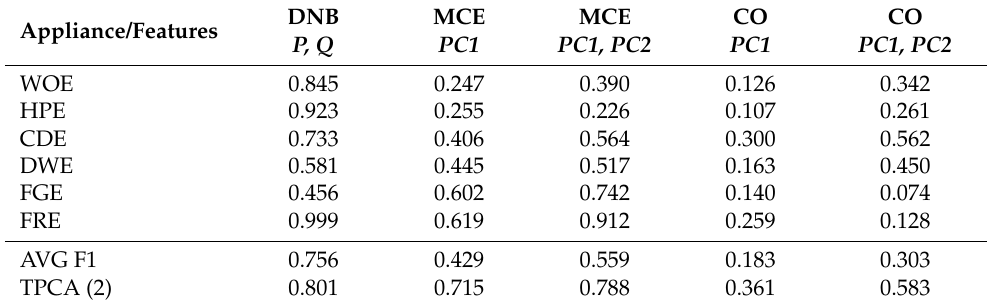
Table 6. Comparison to MCE and CO Methods.